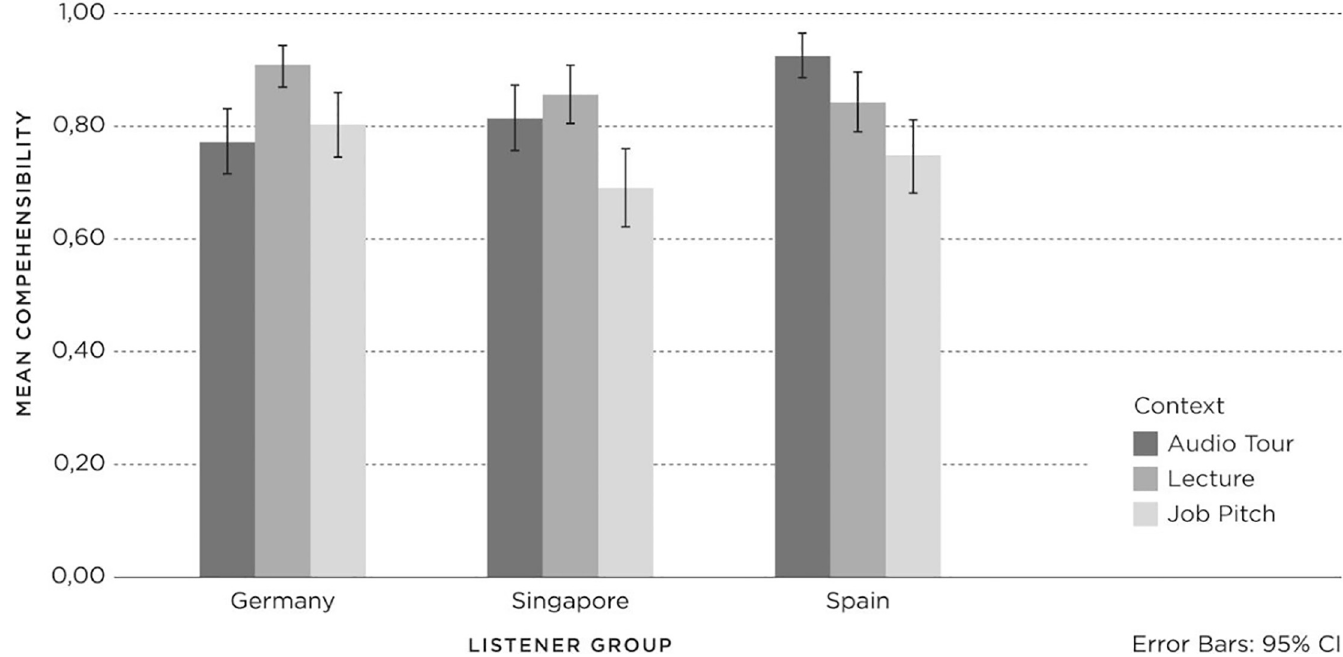
Fig 3. Mean proportions of correct comprehensibility for context (Audio Tour, Lecture, Job Pitch) and listener group (Germany, Singapore, Spain).